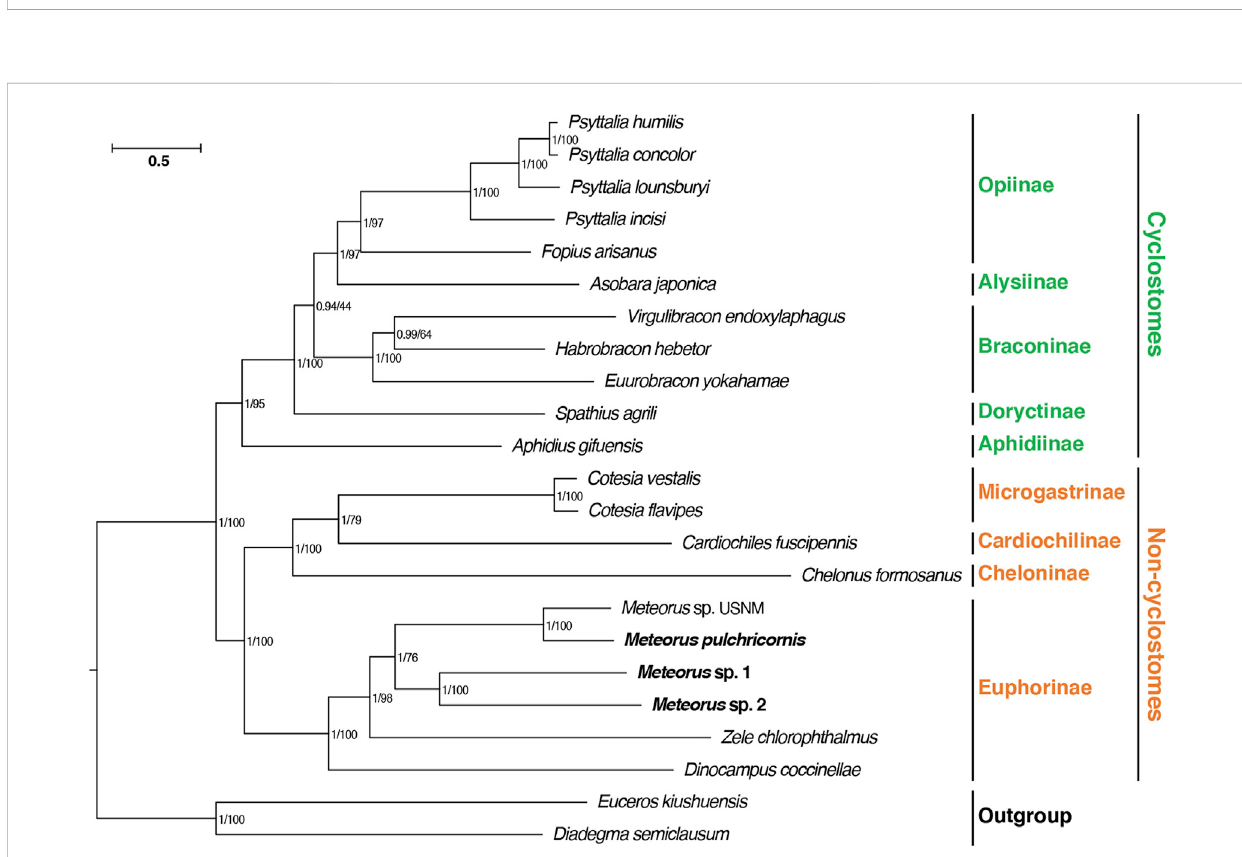
FIGURE 4 Phylogenetic analyses of Braconidae based on nucleotide datasets of 13 PCGs. The scale bar corresponds to the estimated number of substitutions per site. Numbers separated by a slash on the node are posterior probability (PP) and bootstrap value (BV).